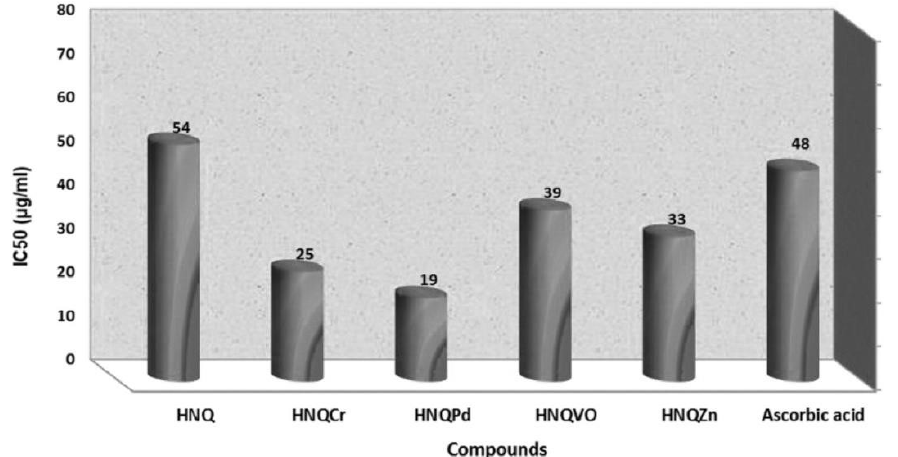
Figure 4. The antioxidant performance of HNQ (1) imine ligand and its Cr(III),VO(II), Zn(II) and Pd(II) complexes (2–5). Reproduced from the permission of ref. [140].